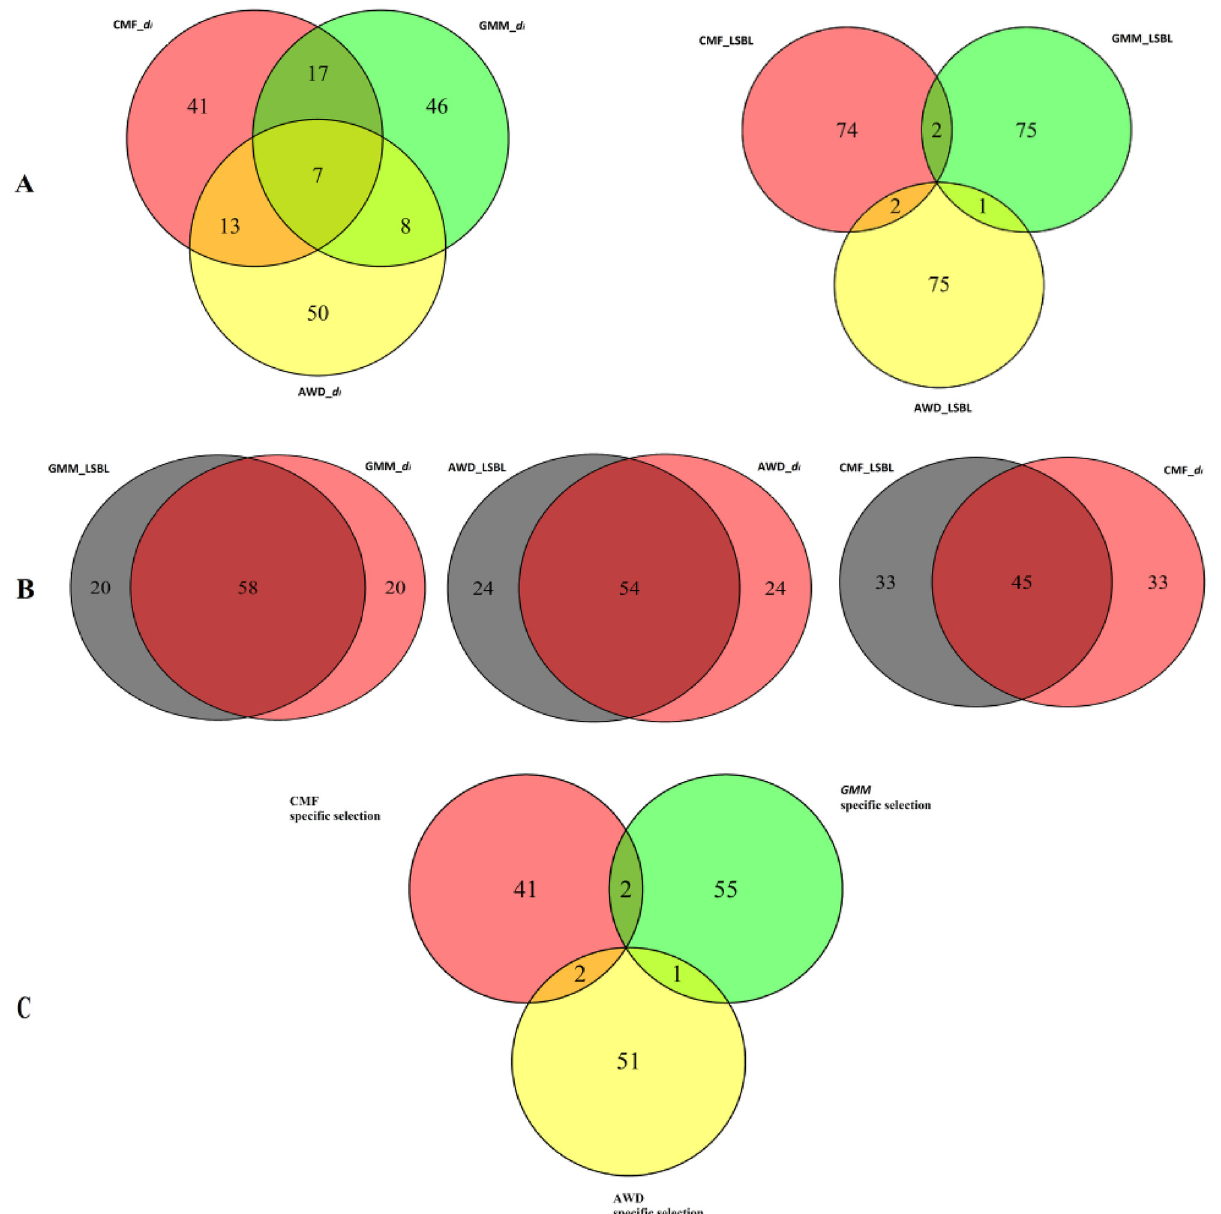
Fig 5. A. Former: Venn diagram of selection windows from d i approach in three breeds, Latter: Venn diagram of selection windows from LSBL approach in three breeds; B. Venn diagrams of each breed ’ s selection windows from LSBL and d i approaches; C. Venn diagram of specific selection windows in three